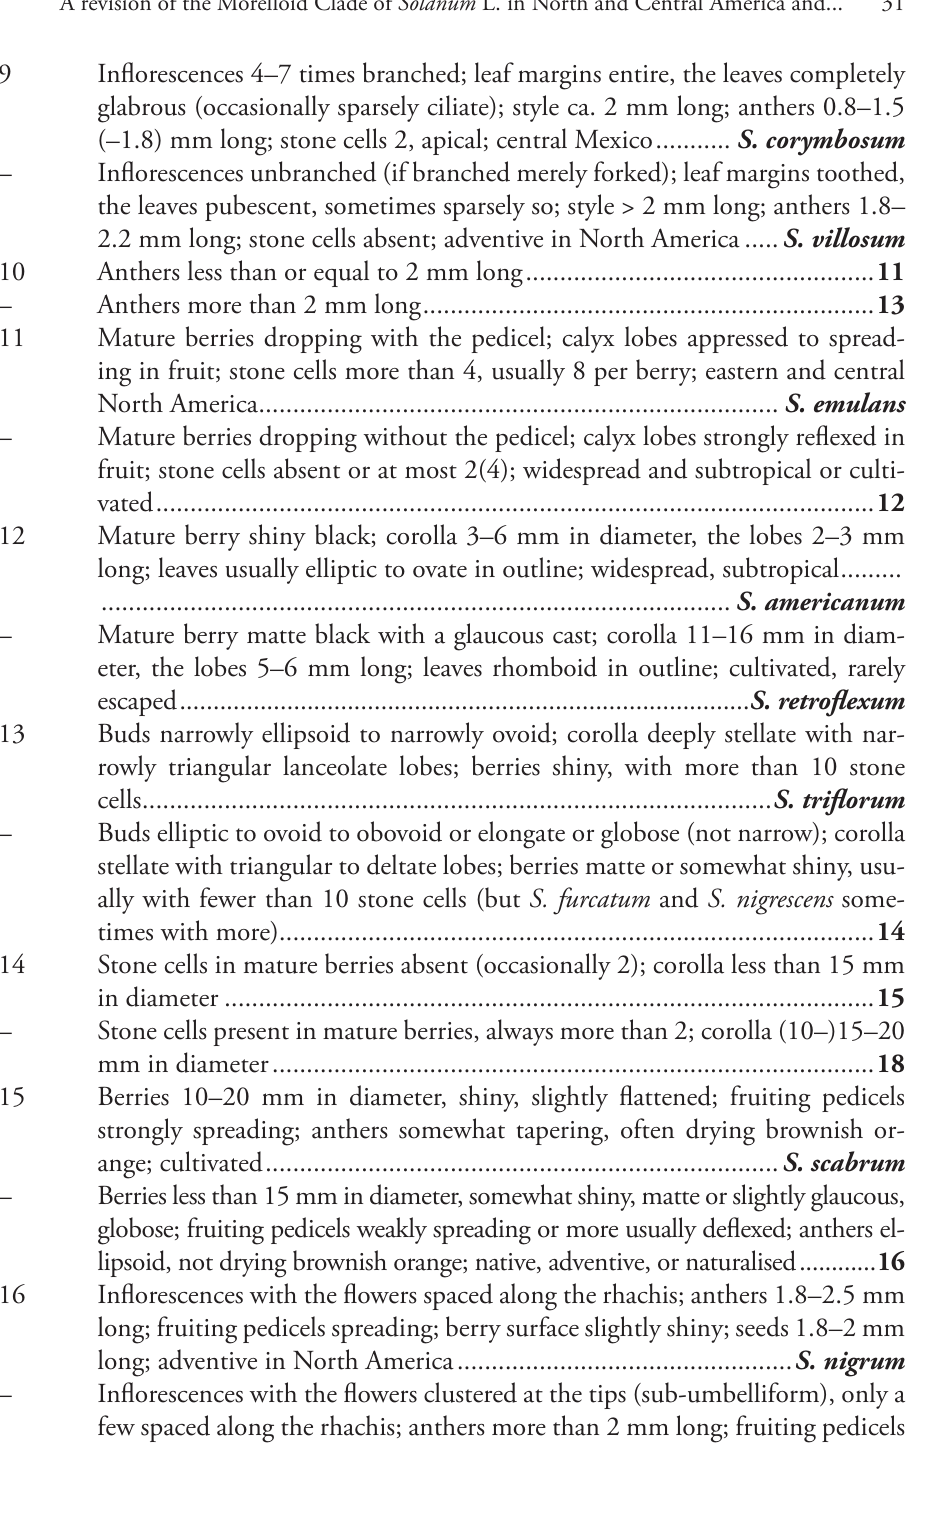
lipsoid, not drying brownish orange; native, adventive, or naturalised ............ 16 16 Inflorescences with the flowers spaced along the rhachis; anthers 1.8–2.5 mm long; fruiting pedicels spreading; berry surface slightly shiny; seeds 1.8–2